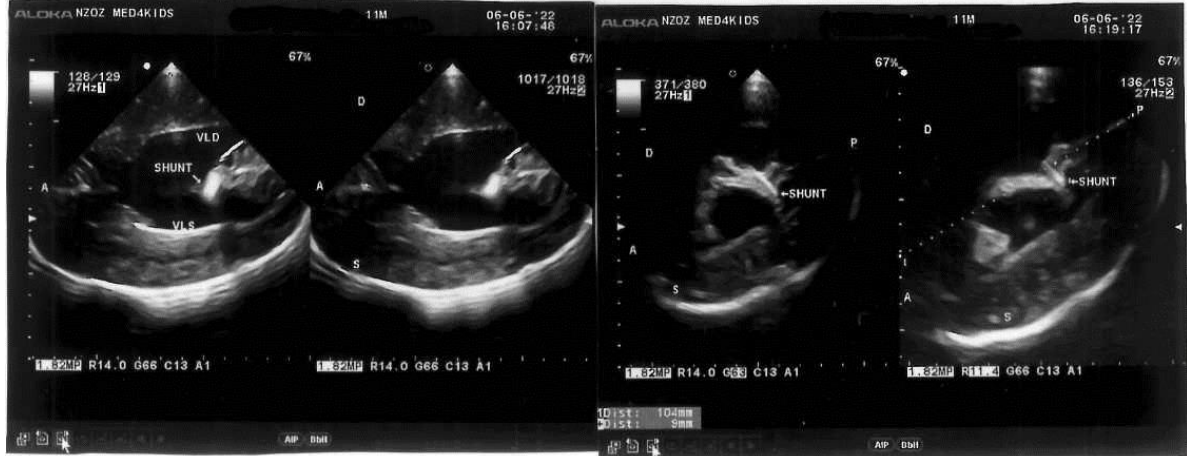
Figure 5. Transcranial ultrasound image of the patient at 11 months postdelivery. ( Right ): Evans index: 0.35. Dilated occipital horn of the lateral ventricles. Ventricular septal defect. Corpus callosum hypoplasia. Subarachnoid cranio-cortical spaces with fluid space. ( Left ): Ventriculoperitoneal shunt passes through the right lateral ventricle below its body and is located in the left lateral ventricle.